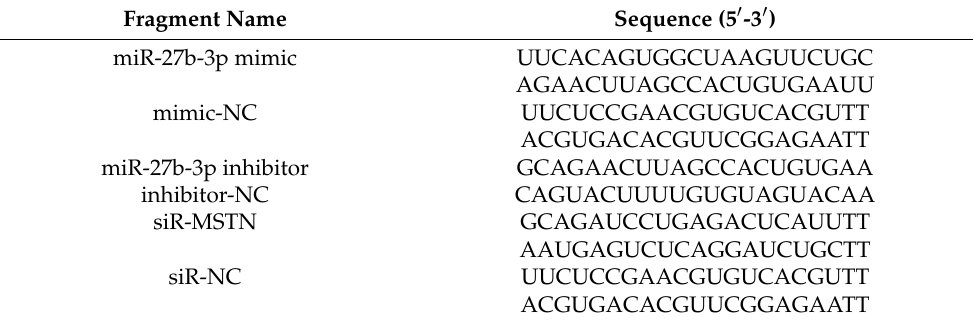
Table 3. Oligonucleotide sequences for overexpression and